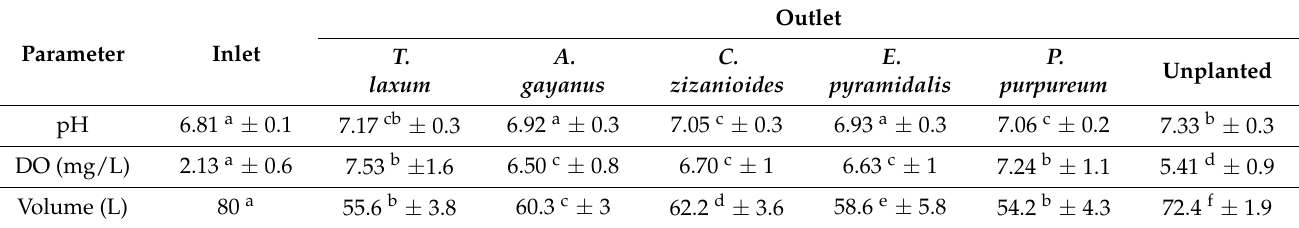
Table 3. Mean and standard deviation of pH, dissolved oxygen (DO) and water volume at the inlet and outlet of the pilot VFCW beds with different plant species. Values within the same column followed by the same superscript letter (i.e., a, b, c, d, e, f) are not statistically significantly different at p <